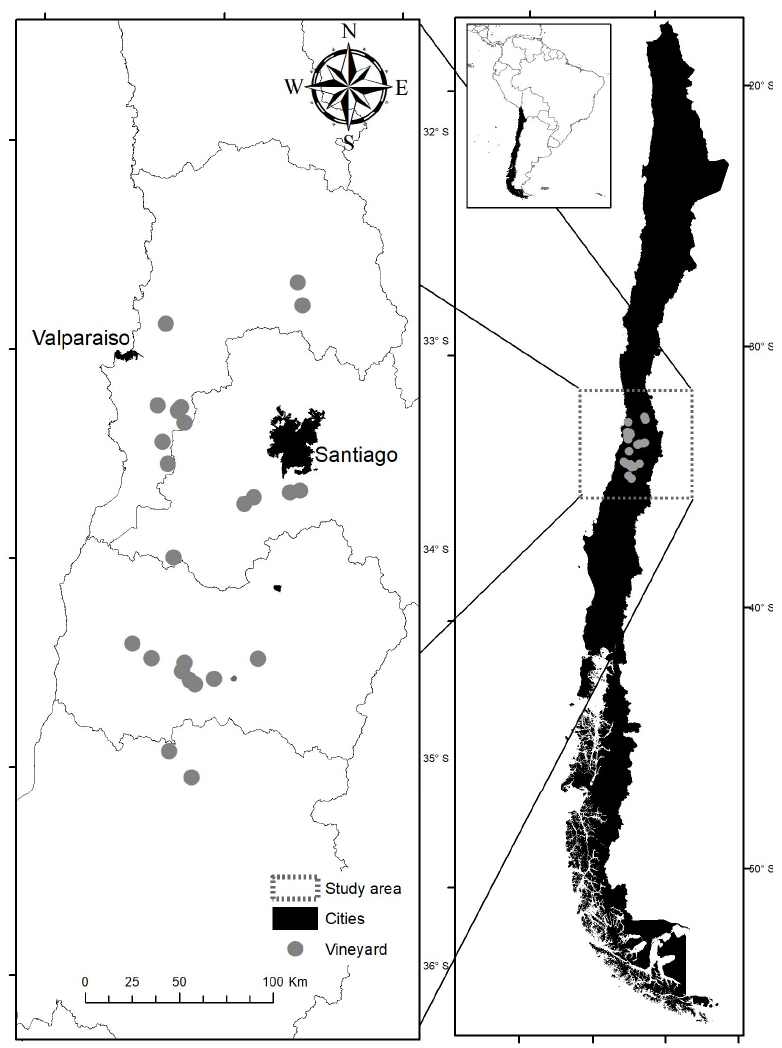
Figure 1. Map of central Chile showing the location of study sites. Gray circles indicate sampled vineyards, found mostly in the central valley and coastal range.